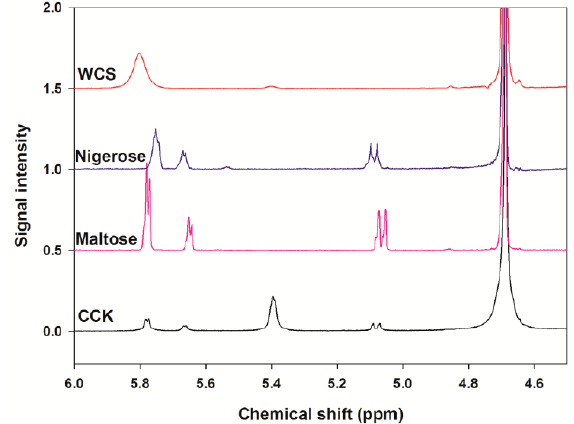
Figure 4. Comparison of the 1 H-NMR spectra (400 MHz, D 2 O) for CCK-oligosaccharides, maltose, nigerose, and waxy corn starch (WCS) (from the bottom). Table 1. Relative abundance (%) of α -1,4 and α -1,6 linkages in the CCK-oligosaccharides and WCS.